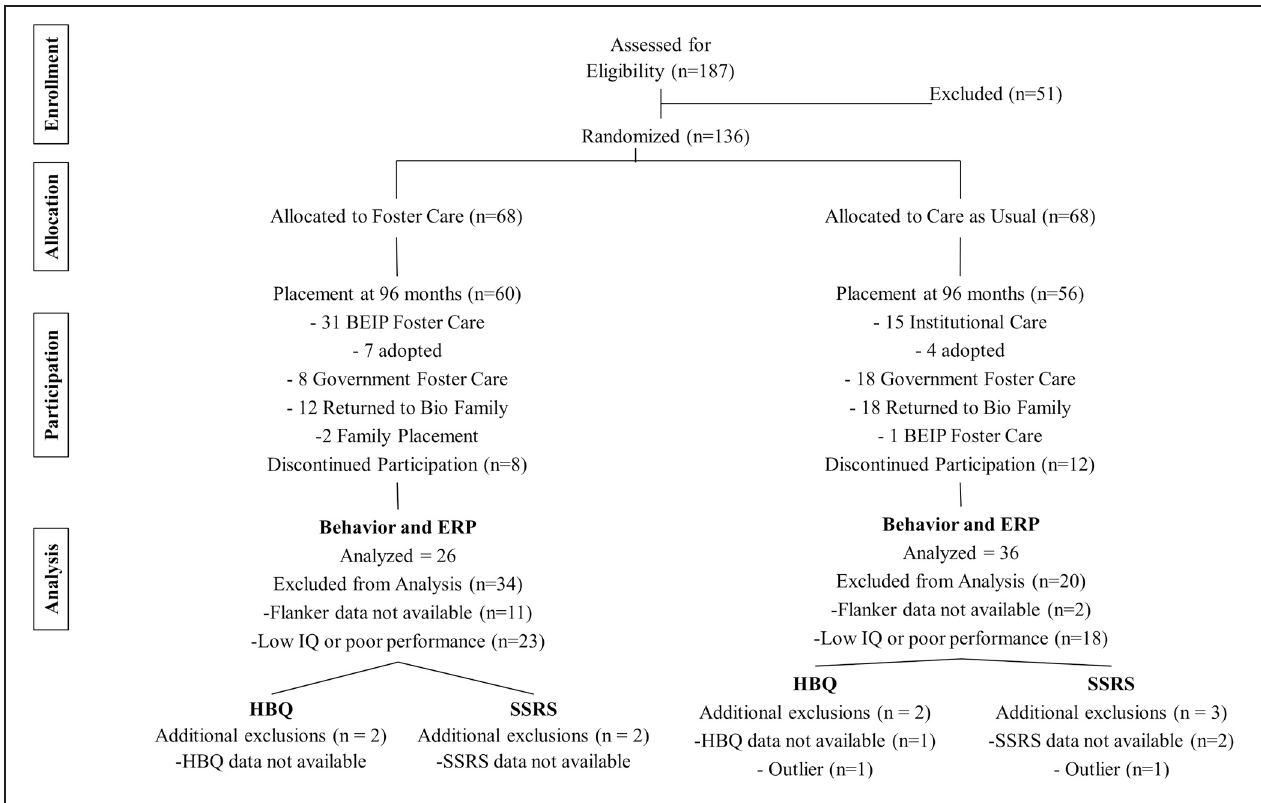
FIGURE 1 | Group assignment over time: current status at 8 years of age.